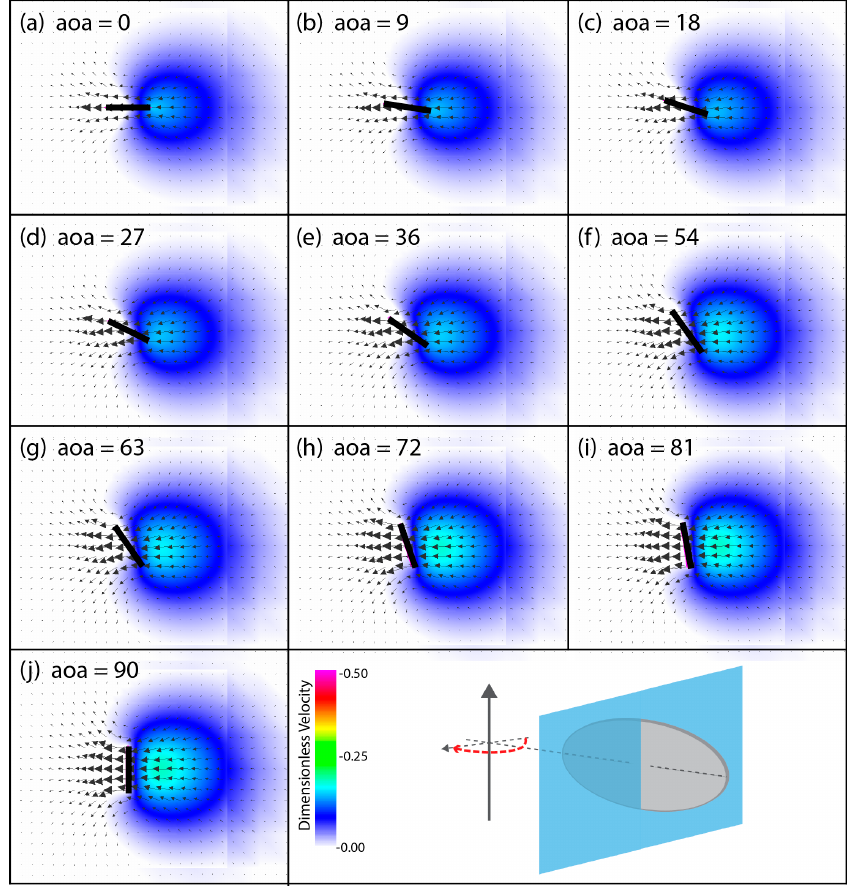
Figure 11. The vector fields and spanwise flow at mid-stroke obtained from three-dimensional computational simulations ( Re = 4, angle of attack range from 0° to 90°). The cross-section shown is through the chord at the midpoint of the span. The vectors show the direction of flow and are scaled to the magnitude of the flow velocity. The color map shows the spanwise flow (min = 0 and max = 0.5) in the direction normal to the plane. Note that the wing is traveling to the left.